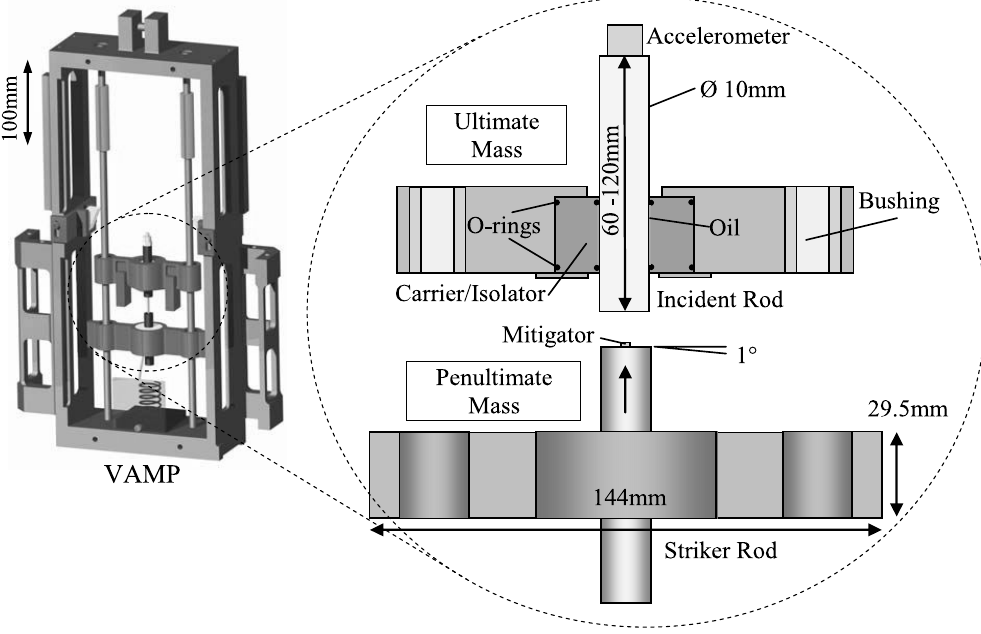
Fig. 3. VAMP model highlighting the penultimate and ultimate masses with interchangeable test rod